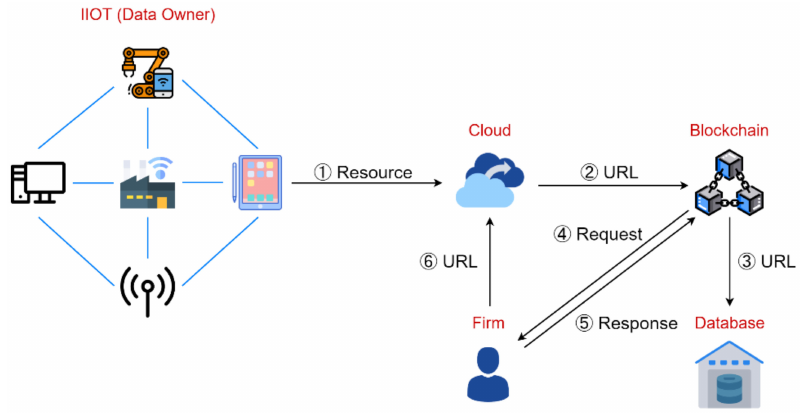
Figure 11. Hyperledger-IIoT Architecture.